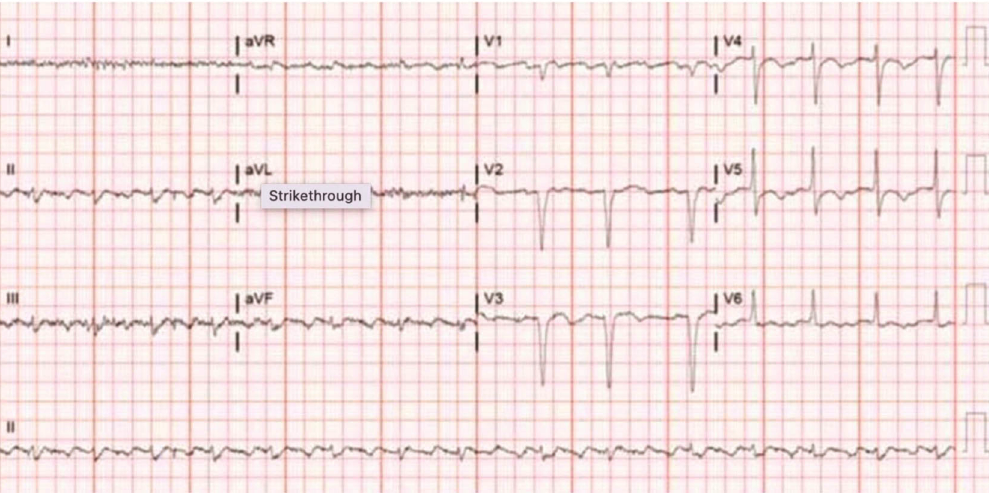
Figure 2: ECG showing atrial fl utter after administration of metoprolol and